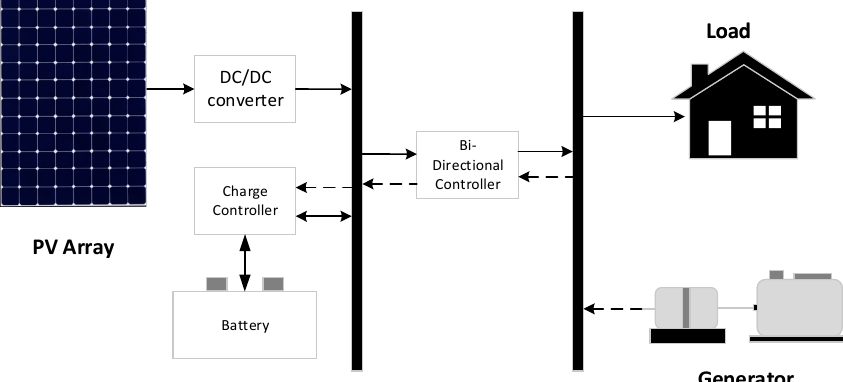
Figure 2. Hybrid photovoltaic (PV) / GTG (Gas turbine generator) system Figure 2 . Hybrid photovoltaic (PV)/GTG (Gas turbine generator) system configuration .